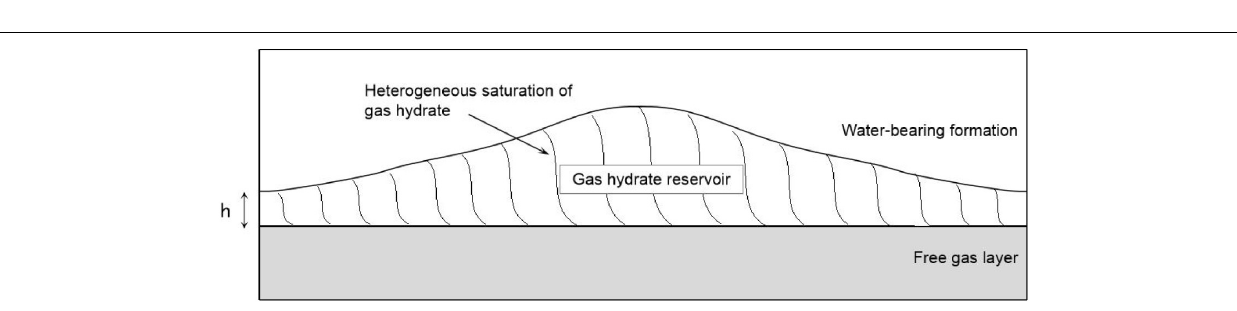
Frontiers in Earth Science |